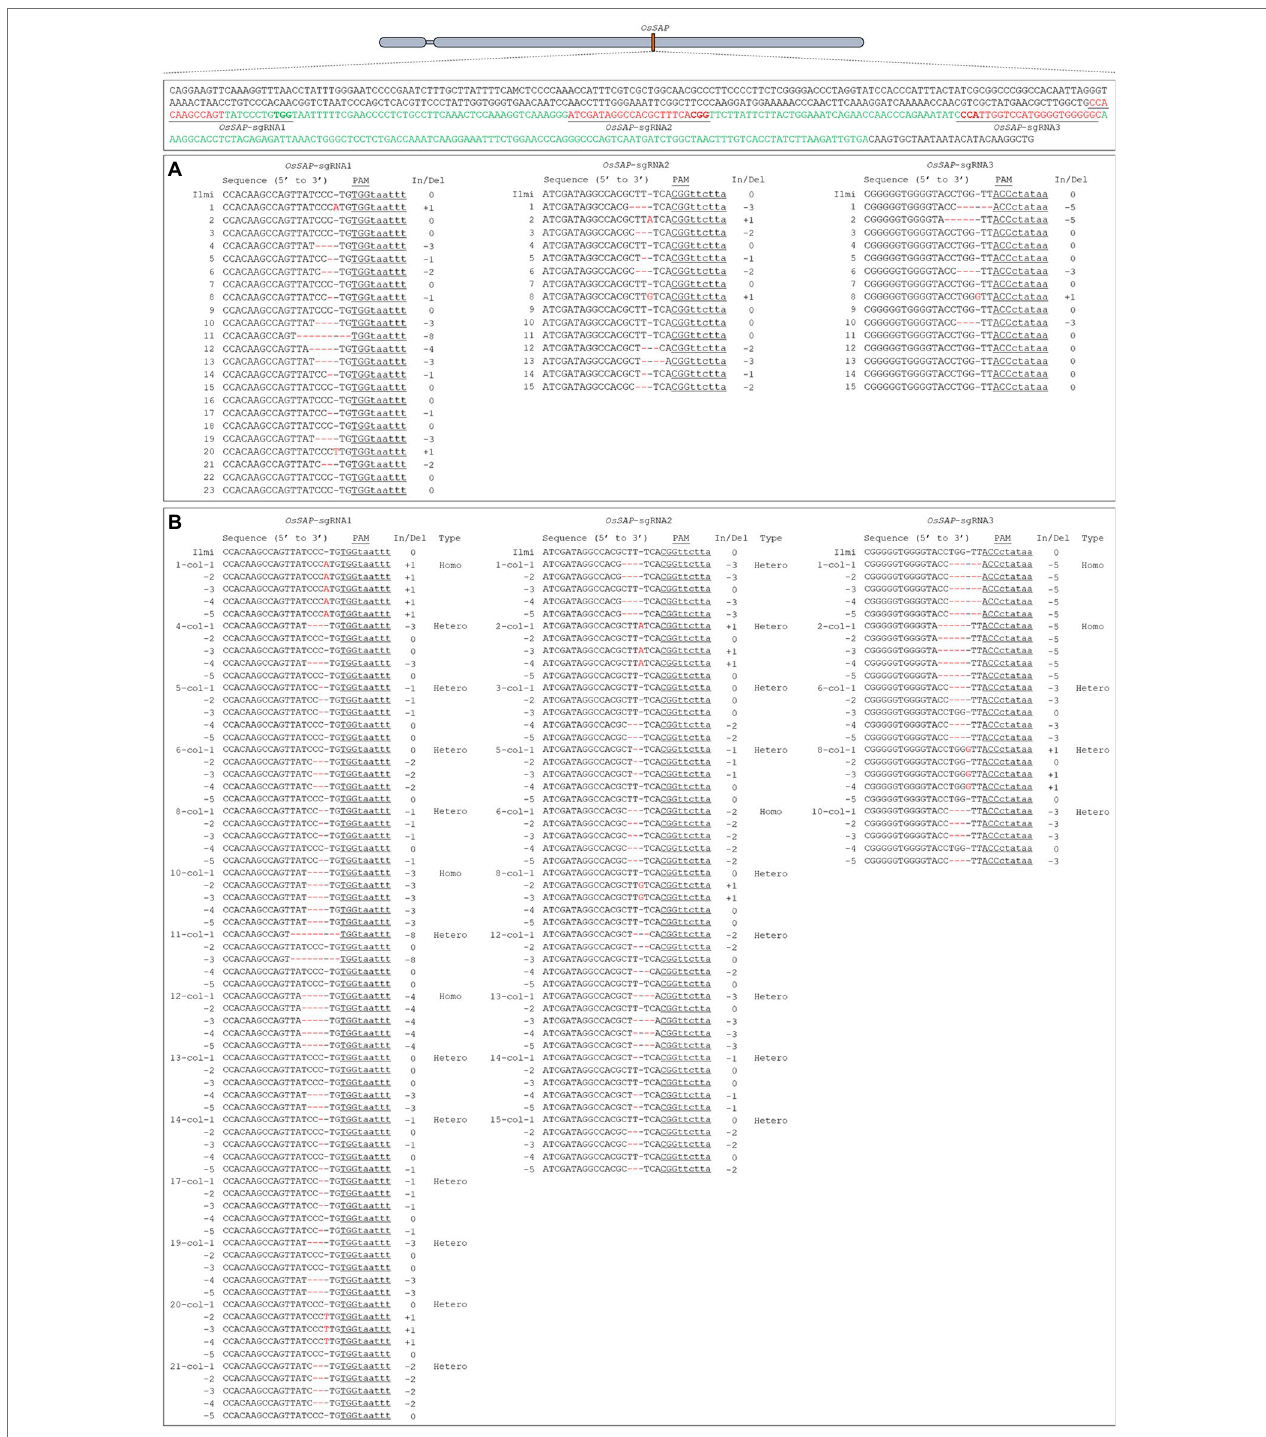
FIGURE 3 | Guide RNA design and genome-editing analysis of target sequence for OsSAP genome editing. (A) The insertion or deletion sequences of target regions are ranked as hyphens ( − ) with deletion, or plus (+) with insertion. When OsSAP -sgRNA1 was used, 14 genome editing regenerated lines were edited; with OsSAP -sgRNA2, 10 were edited, and with OsSAP -sgRNA3, five regenerated lines were analyzed. (B) Analysis of CRISPR/Cas9-mediated genome-editing type. When guide OsSAP -sgRNA1 was used, editing occurred in 14 genome-editing lines, of which three regenerated lines were homozygous and 11 were heterozygote. In OsSAP -sgRNA2, out of 10 genome-editing lines, only one was homozygous and the rest were heterozygote. For OsSAP -sgRNA3, five genome- editing lines were edited, with two of those lines being homozygous, and the others were heterozygote. Red color: OsSAP -sgRNAs sequence. Green color: Motif sequence of OsSAP